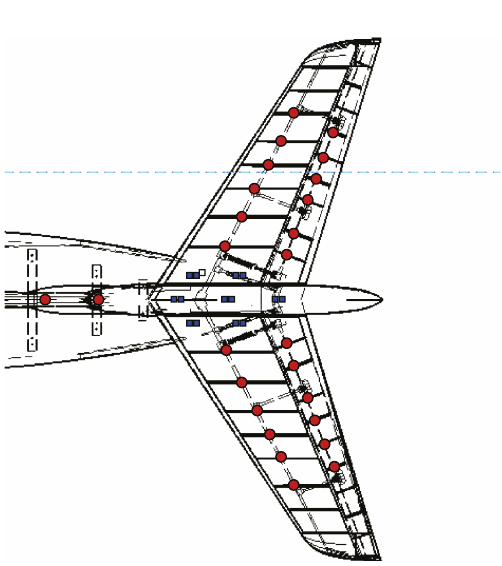
Figure 1: CNN architecture.